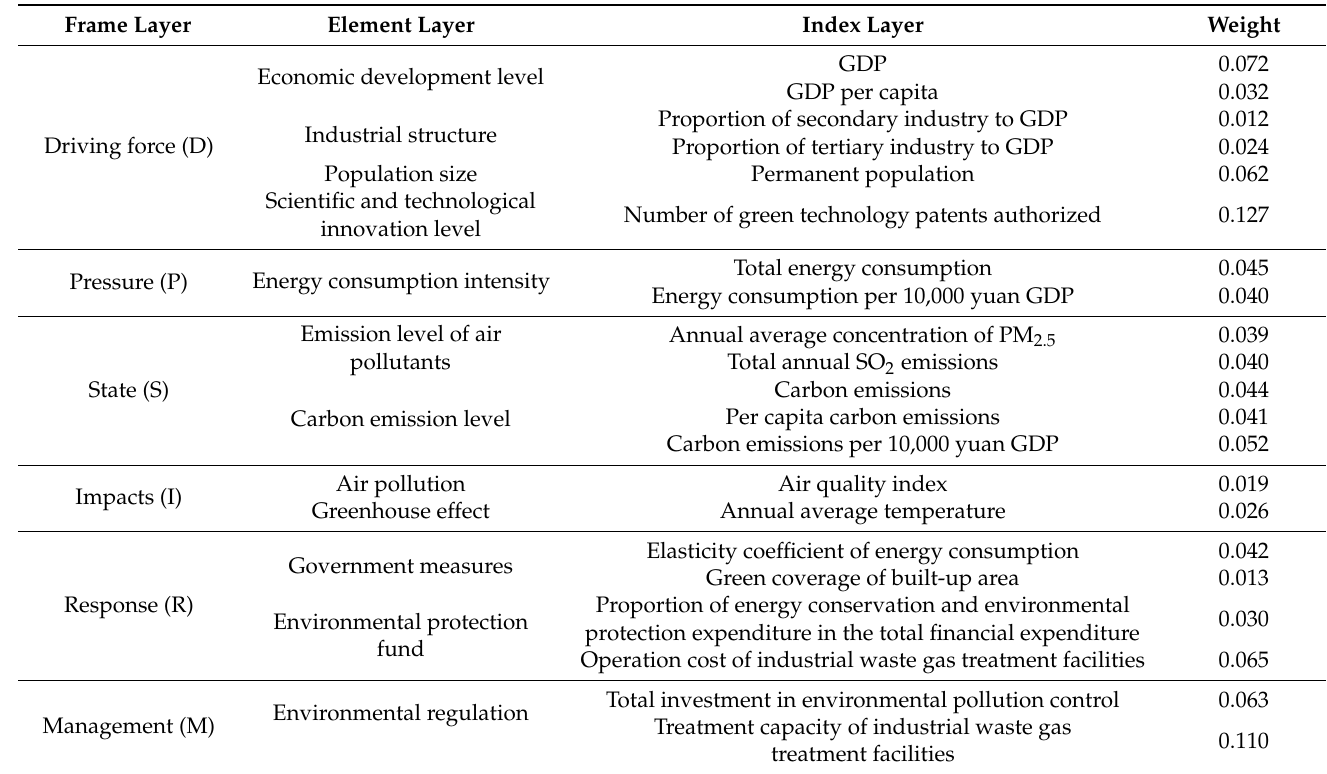
Table 1. Evaluation index system of the co-benefits of carbon reduction and air pollution